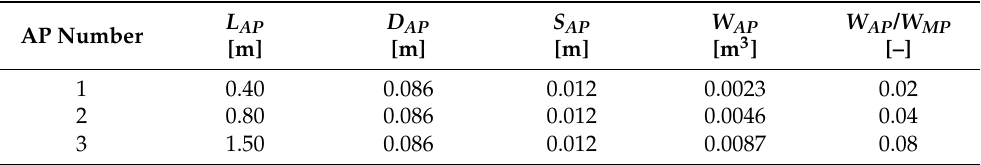
Table 1. Parameters of the additional pipes used in experiments.